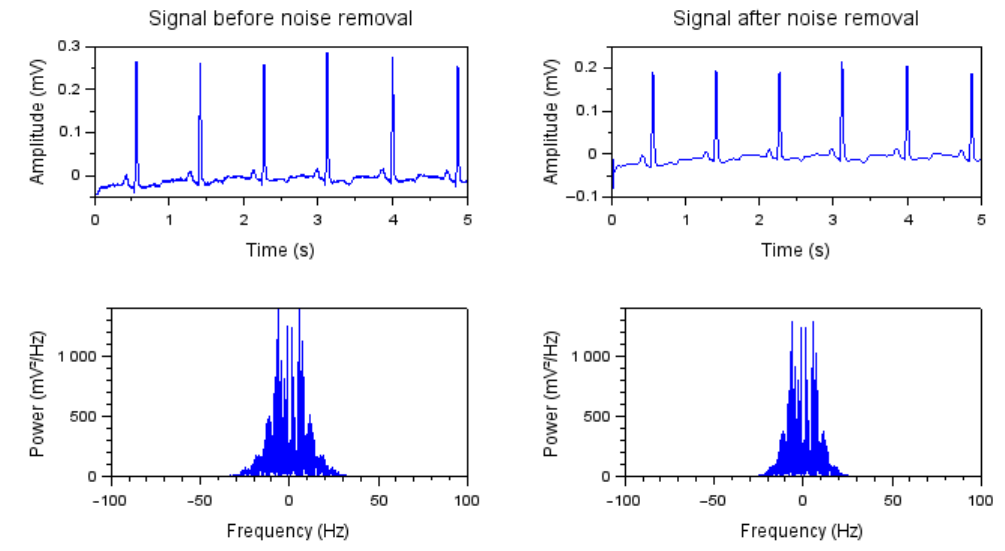
Figure 8. ECG signals power as a function of frequency before and after noise